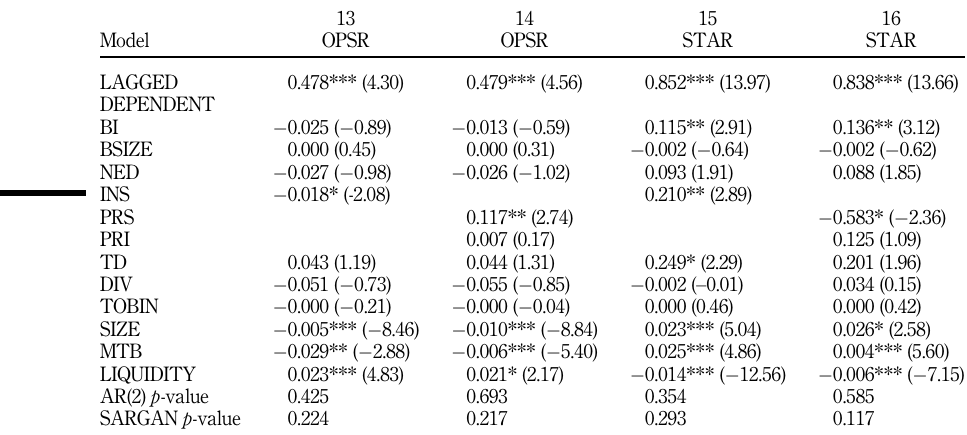
Table 6. Result for high- profit firms